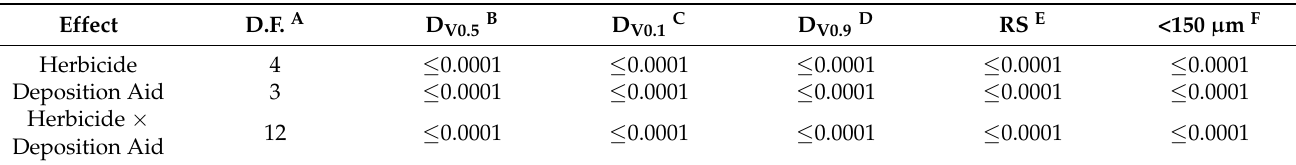
Table 10. Analysis of variance and associated p -Values for droplet size parameters of herbicide solutions and deposition aids applied to soybean.